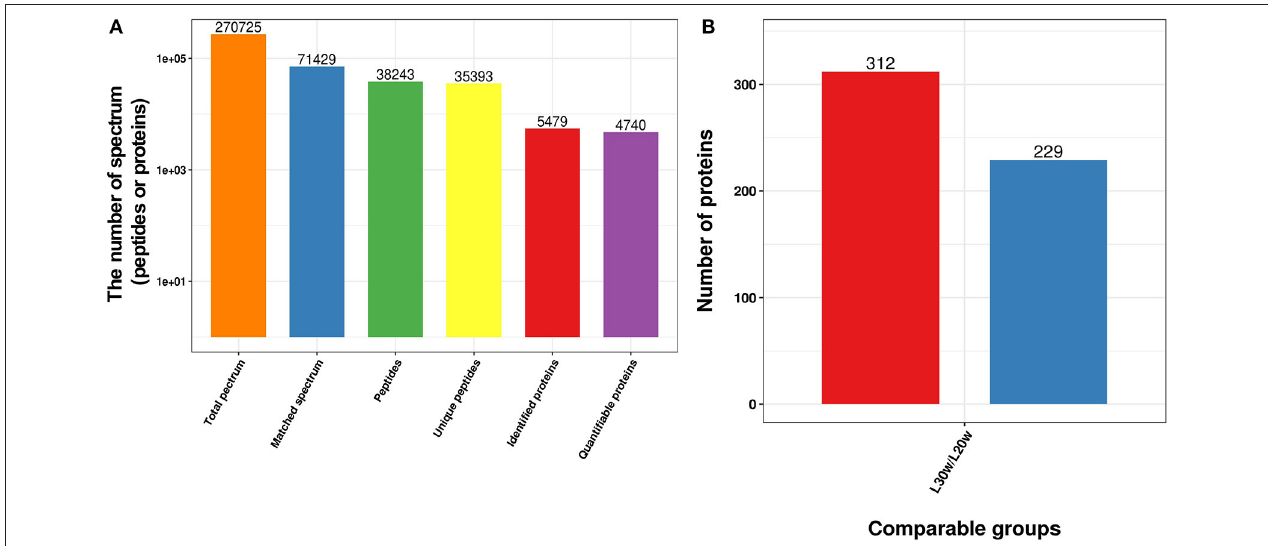
FIGURE 1 | Overview of the SDEPs in livers of chickens at the age of 20 and 30w. (A) Basic statistics of mass spectrometry data. (B) Statistics of SDEPs.